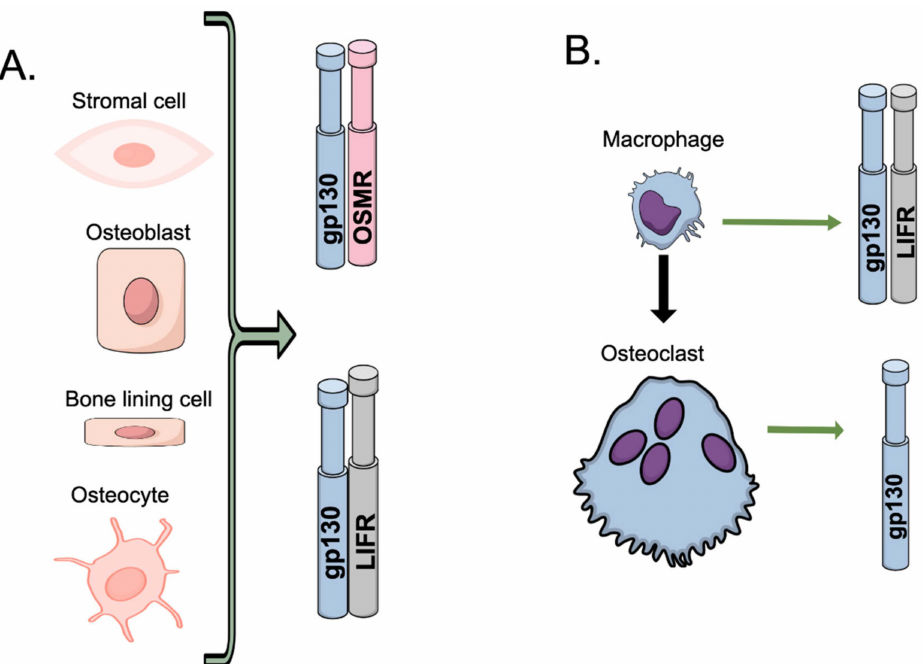
Figure 3. Expression of receptors recognizing OSM by bone cells. ( A ) Bone cells from mesenchymal origin, including bone marrow stromal cells, osteoblasts, bone-lining cells and osteocytes, express gp130, OSMR and LIFR. ( B ) Macrophages express gp130 and LIFR, but osteoclasts express only gp130, possibly because of downregulation of LIFR after treatment of macrophages with RANKL